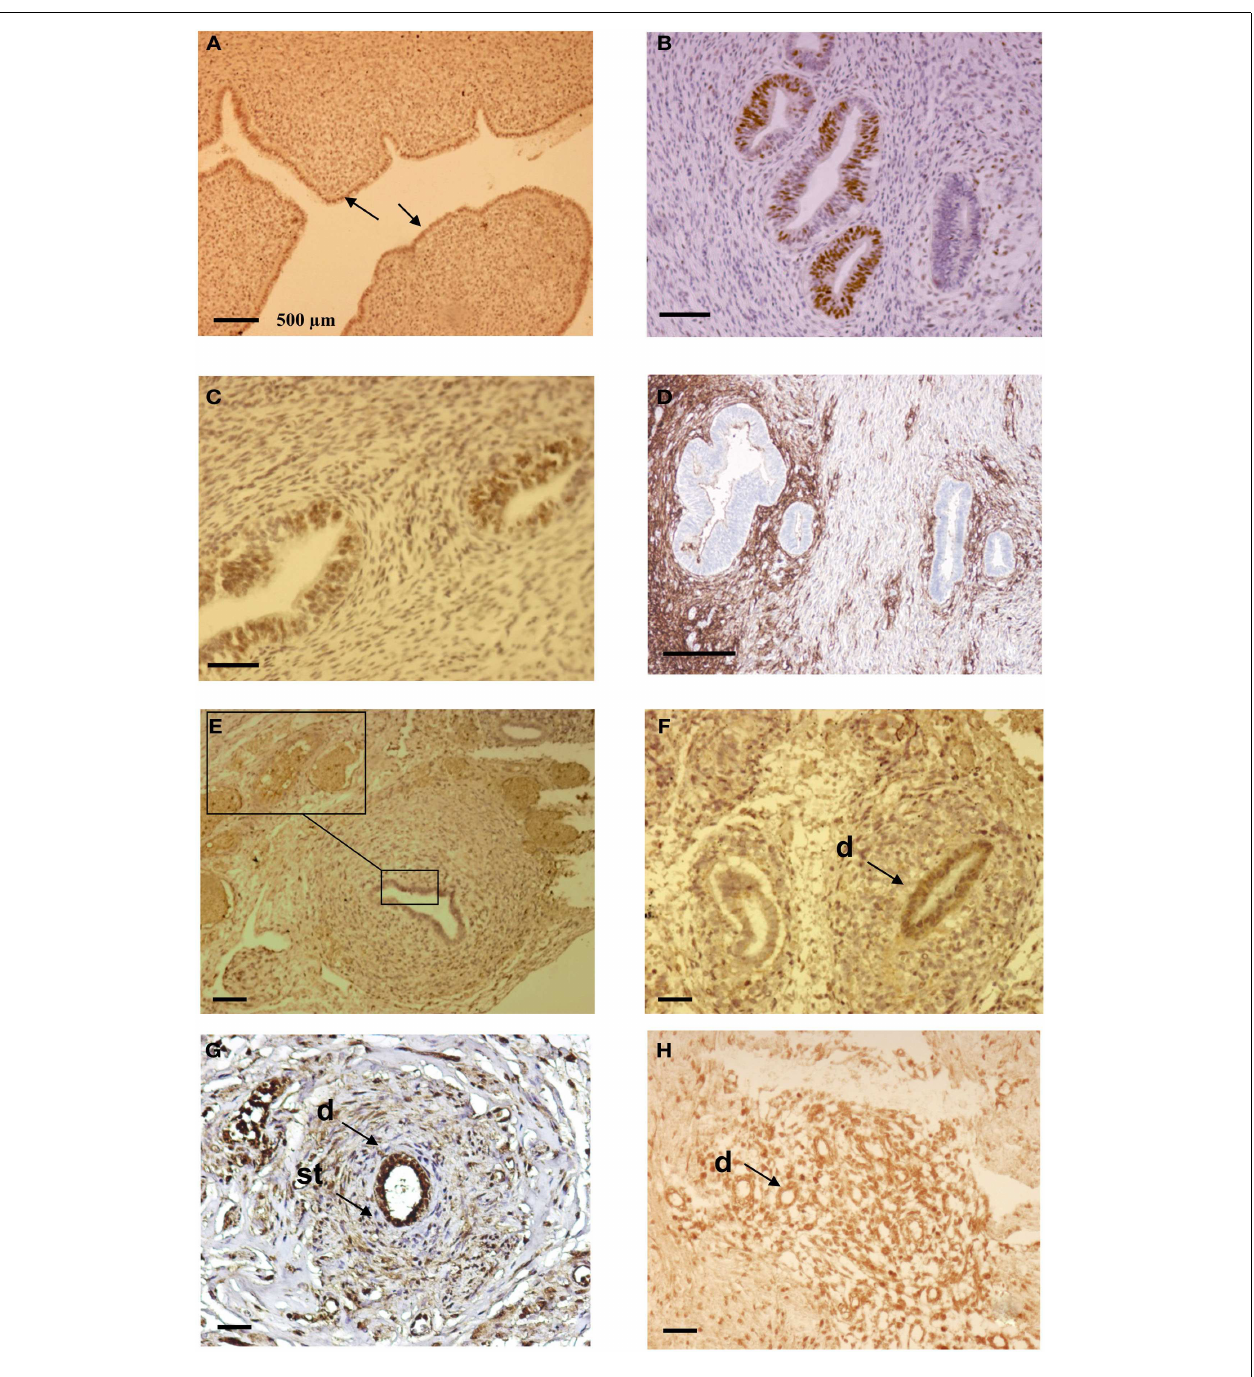
Expression of the PR in embryonic duct located in the ovarian ligament; insert at higher magnification (E) , expression of ER- α in a duct located under the fallopian tube serosa (F) , and expression of alpha-1-fetoprotein (G) and CD10 molecules (H) . D = duct; St = stromal layer. Scale bars; 500 µ m in (A) and 100 µ m in (B–H)